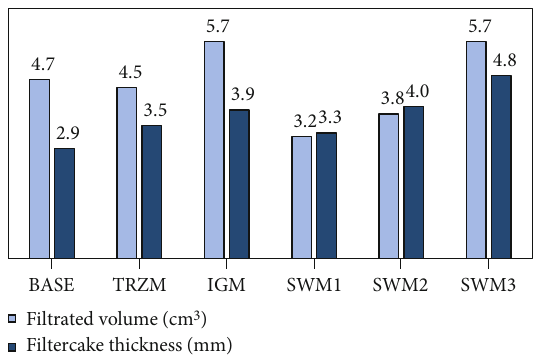
Figure 6: The fi ltration characteristics of the prepared